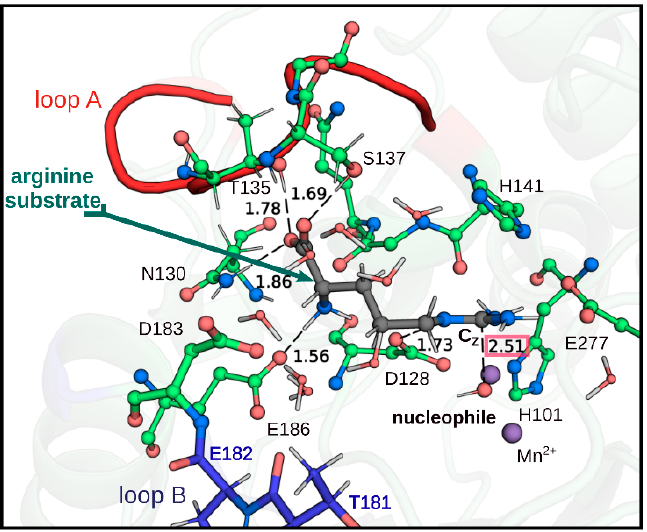
Figure 7. Optimized structure of the Michaelis–Menten complex reactant with arginine substrate of arginase D181T/V182E double mutant at the B3LYP/6-31+G*:CHARMM36 level. The distances are in Å.